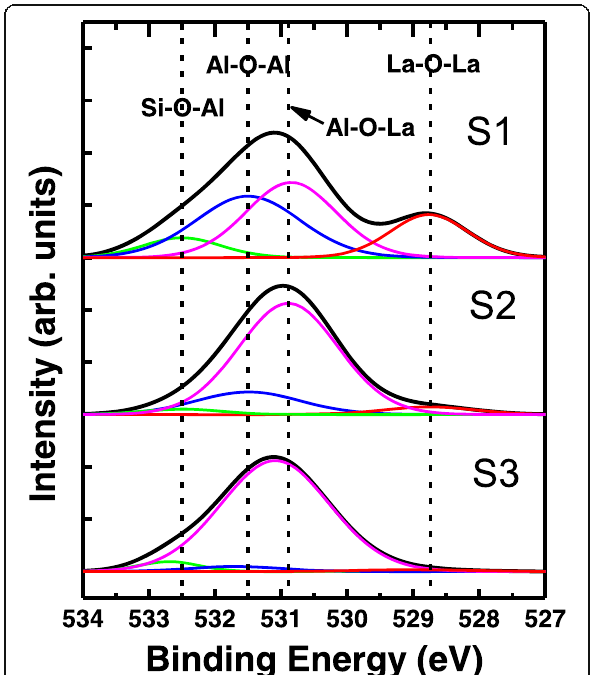
Fig. 5 O1s XPS spectra of samples S1 – S3. The O1s spectra